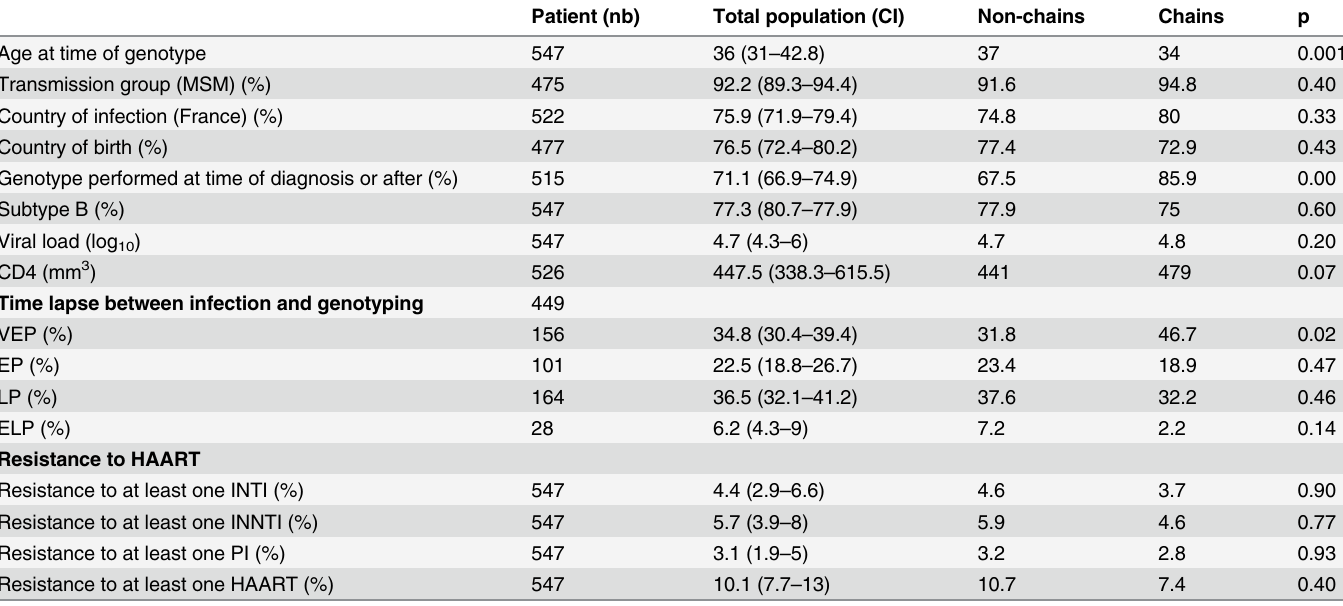
Table 1. Comparison of the characteristics of chained and non-chained